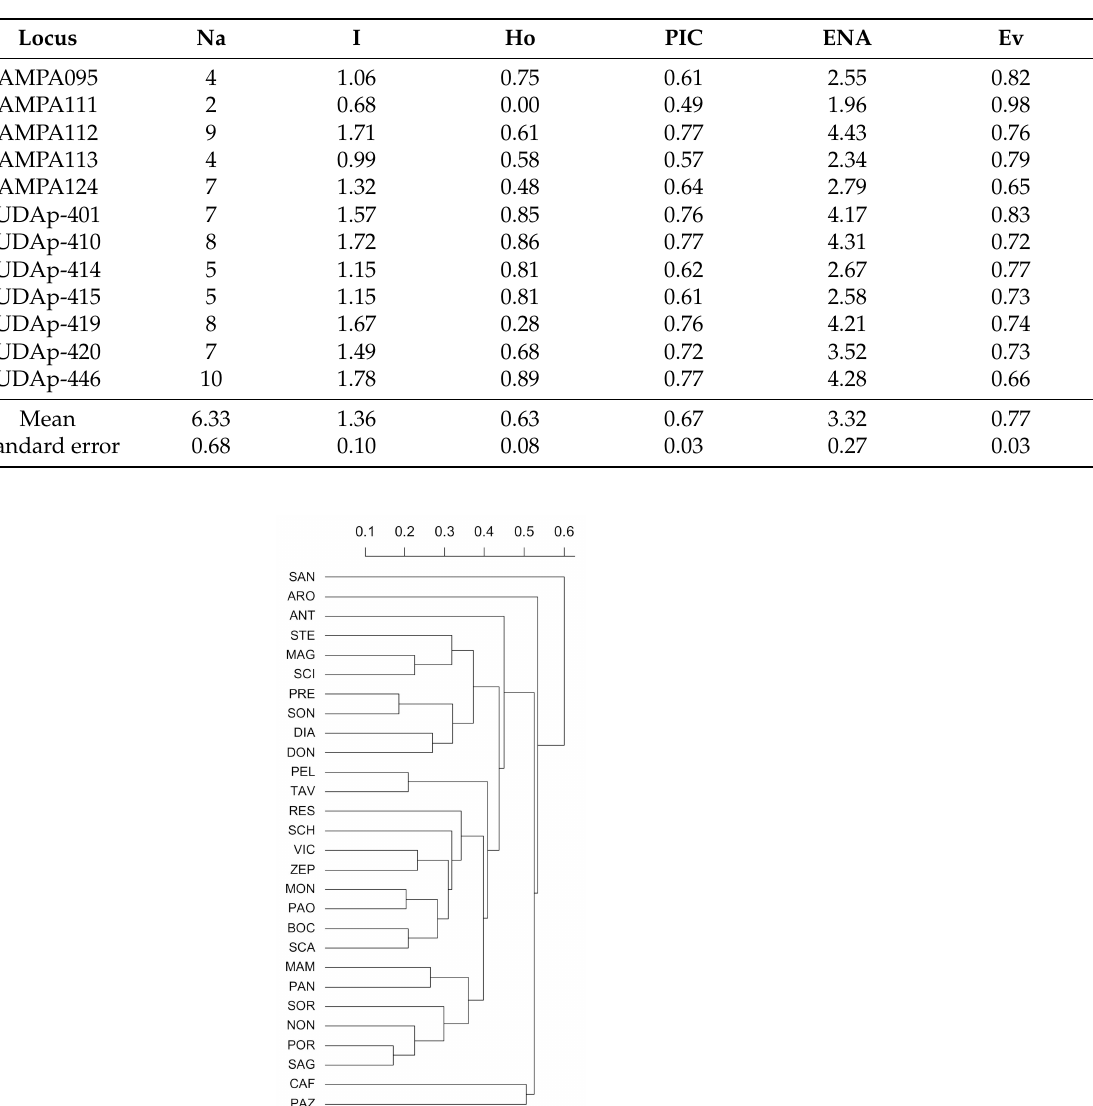
Table 3. Main genetic indices of the apricot landraces obtained by SSR analysis. Na: number of different alleles; I: Shannon’s